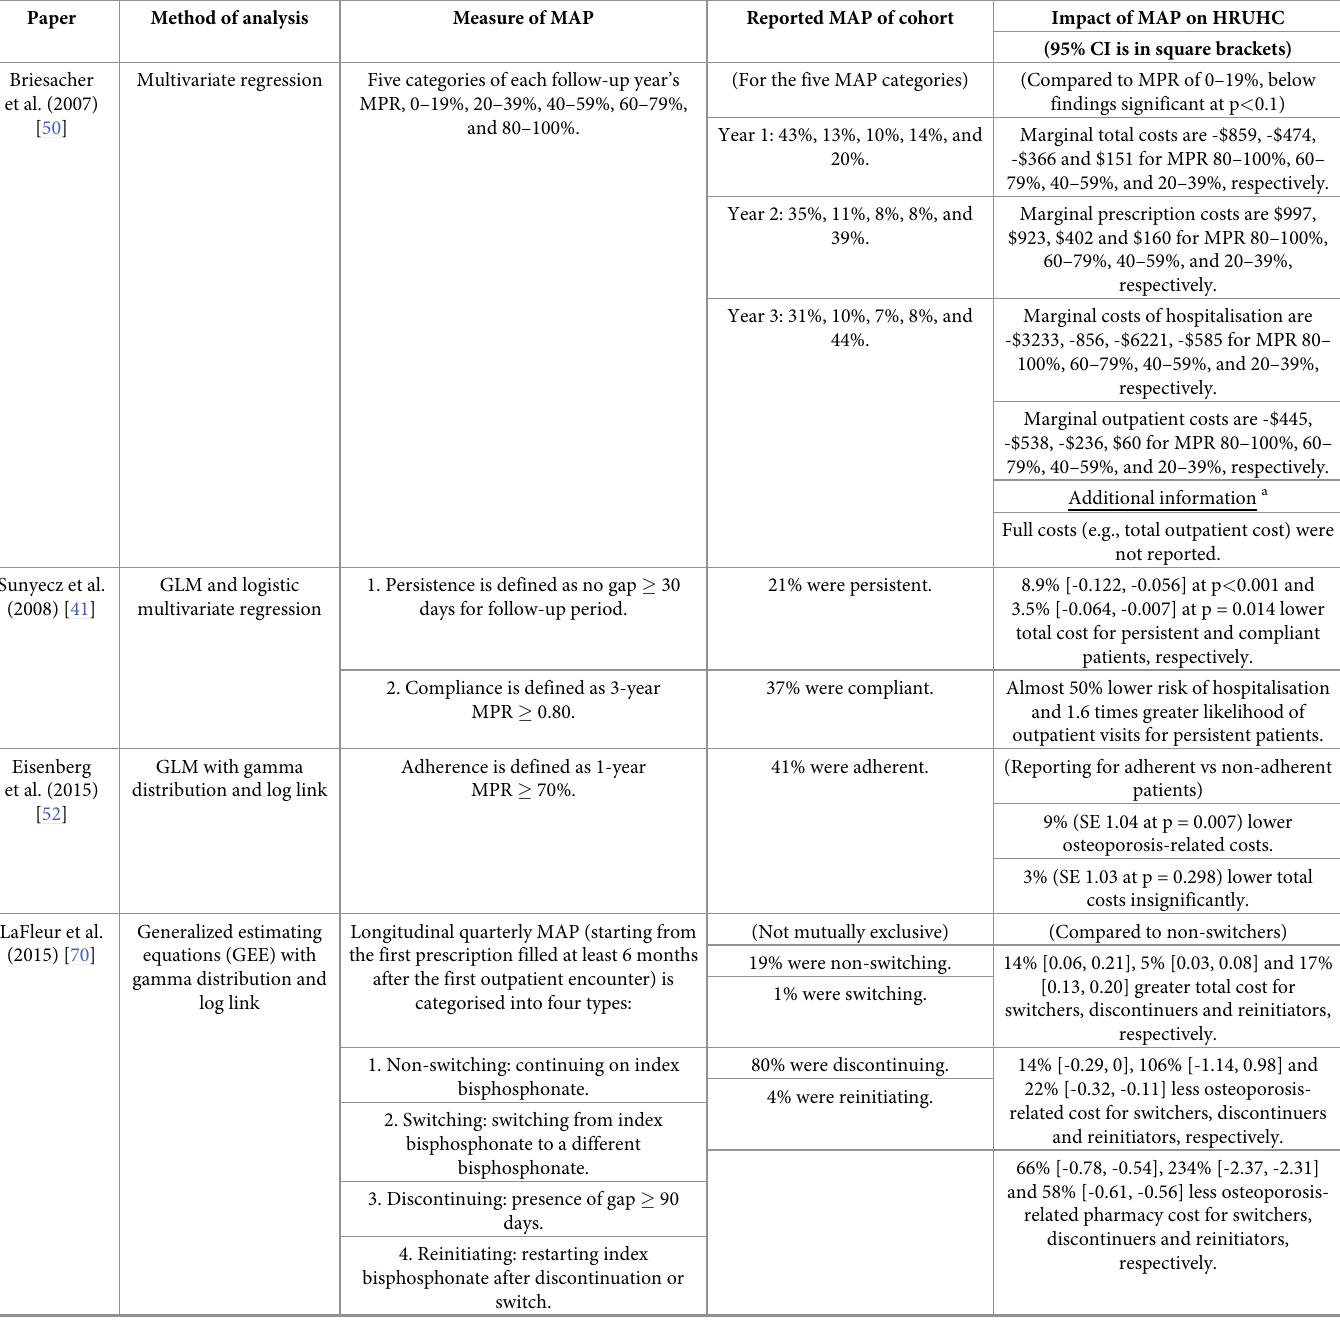
Table 7. Impact of adherence or persistence to bisphosphonates on healthcare resource utilisations and healthcare costs.